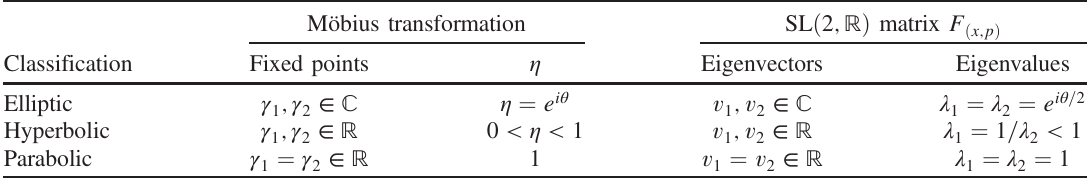
TABLE I. The dictionary between the Möbius transformation and the SL 2 matrix for the parametric oscillator. Möbius